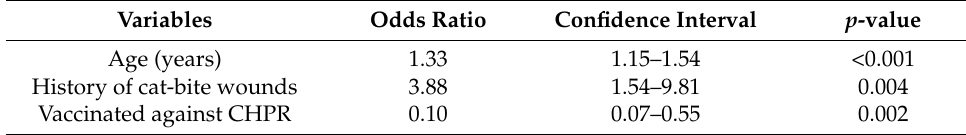
Table 2. Multivariate analysis of risk factors for Toxoplasma gondii seropositivity. Variables Odds